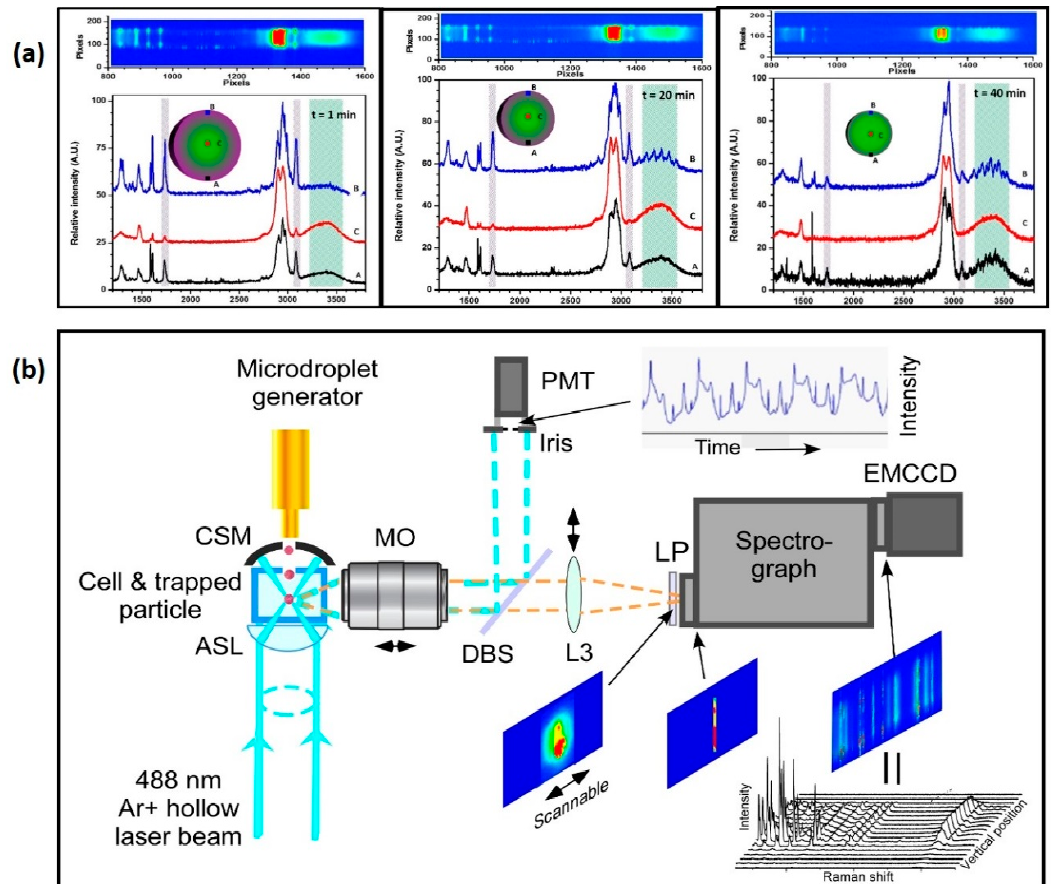
Figure 7. ( a ) Spatially resolved Raman spectra revealed a typical core-shell morphology, with glycerol-rich core, coated with a layer of DEP. Time-resolved spectra showed that DEP evaporated faster than the less volatile glycerol, however, both chemicals in the mixture evaporated at faster rates than within their own pure droplets. ( b ) Experimental setup for measuring position-resolved temporal Raman spectra and particle size from a laser-trapped single airborne aerosol particle. ASL: aspheric lens; CSM: concave spherical mirror; DBS: dichroic beam splitter; L: lens; LP: long-pass filter; M: mirror; MO: microscopic objective; PMT: photomultiplier tube. (Reprinted and adapted from [39], with permission under Creative Commons Attribution License, Copyright (2018) The Royal Society of